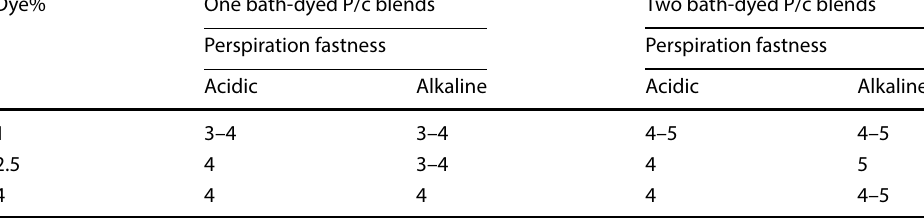
Table 9 Perspiration fastness of treated sample and conventional